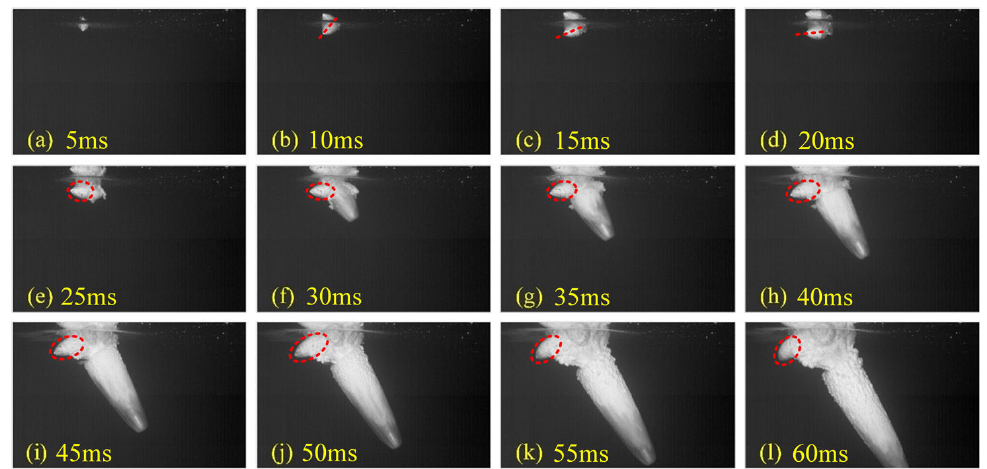
Figure 13. Cavitation evolution of T05 (with No. 1 head cap).